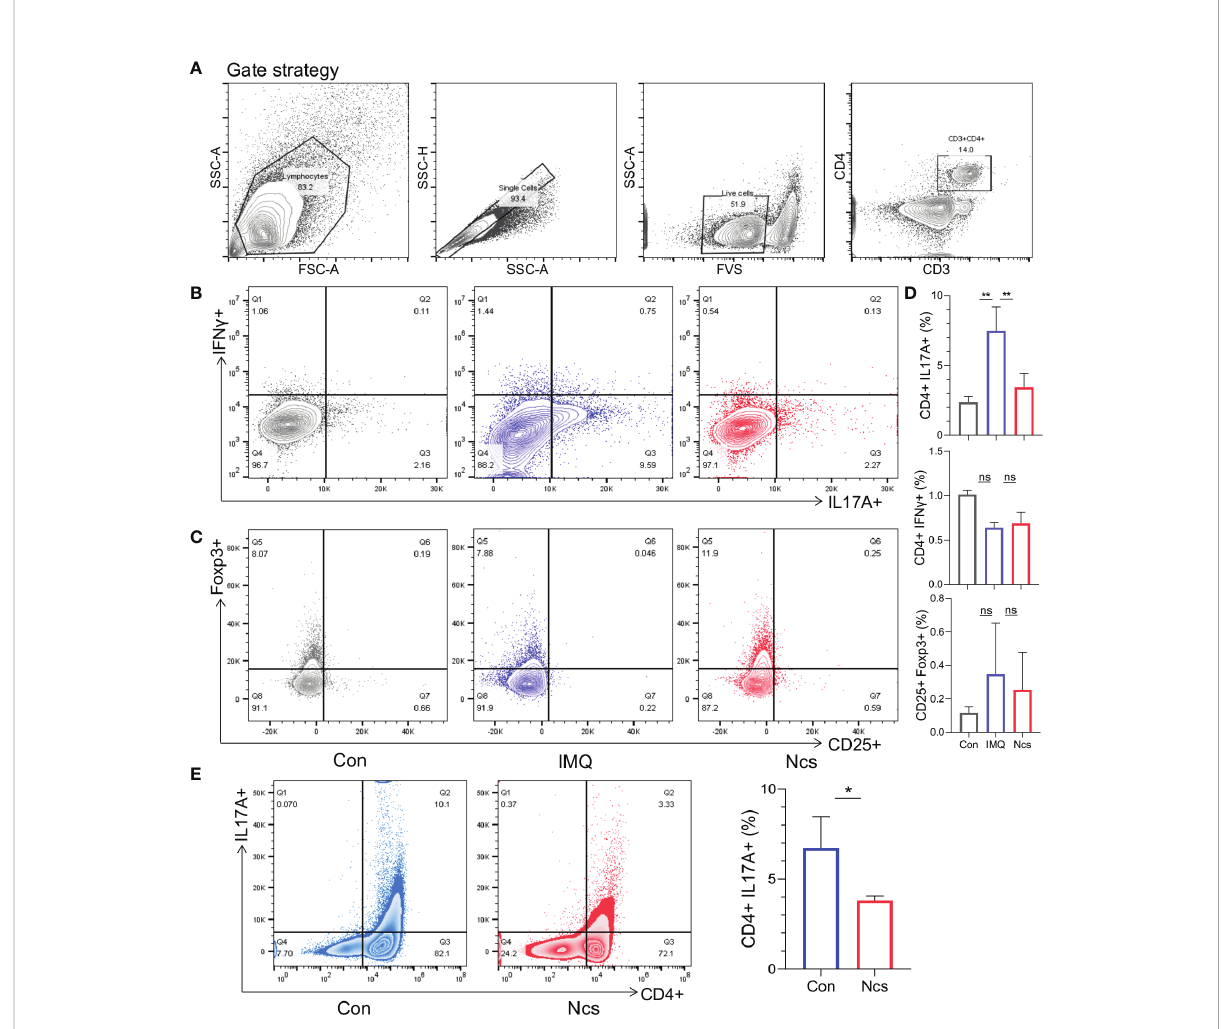
FIGURE 2 Ncs reduced the proportion of Th17 cells in the spleen of IMQ-induced psoriasis-like mice and inhibited Th17 polarization in vitro . As described above, intradermal injection of Ncs(2mg/kg) and topical administration of IMQ were performed on the back of mice. After the mice were sacri fi ced on day 6, spleens were extracted and dissociated into single-cell suspension for fl ow cytometry. (A) The gating strategy of different T cell subtype. (B, C) Representative fl ow cytometric analysis of Th1 (CD4+IFN g +), Th17 (CD4+IL17A+), and Treg (CD25+Foxp3+) cells in splenic CD4+ T cells from each group (n=3). (D) Statistical data are shown in the histogram. (E) Naïve CD4+ T cells from mouse spleen (n=3) were stimulated with anti-CD3 and soluble anti-CD28 under Th17-polarizing condition with or without Ncs in vitro . Five days later, the percentages of CD4+ and Th17 (CD4+IL17A+) cells were detected by fl ow cytometry and statistical data are shown in the right panel. Flow data are representative of three independent experiments with 3 samples per group in each. Data are presented as the mean ± SEM. P-values were determined using t test by Prism 8; * p <0.05; ** p <0.01; ns, no signi fi